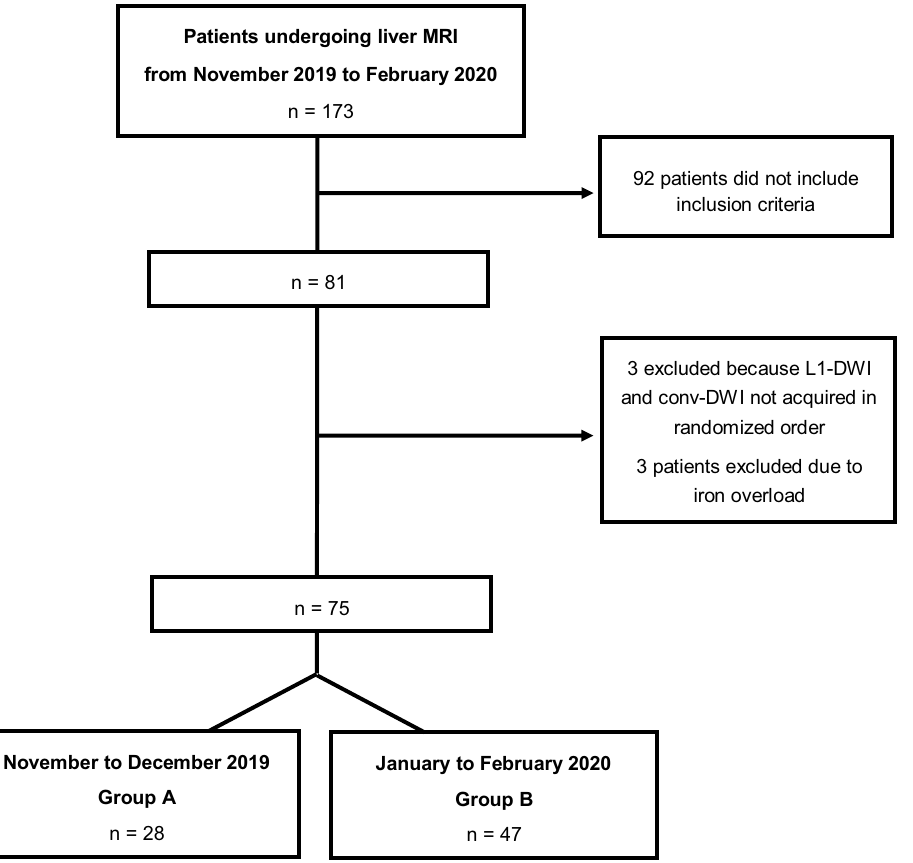
Figure 1. Flow diagram of the patient inclusion